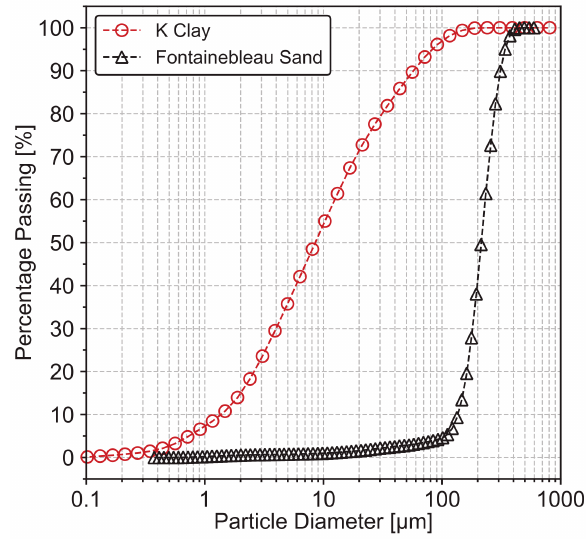
Figure 1. Grain size distribution of Fontainebleau sand NE34 and kaolinite clay.